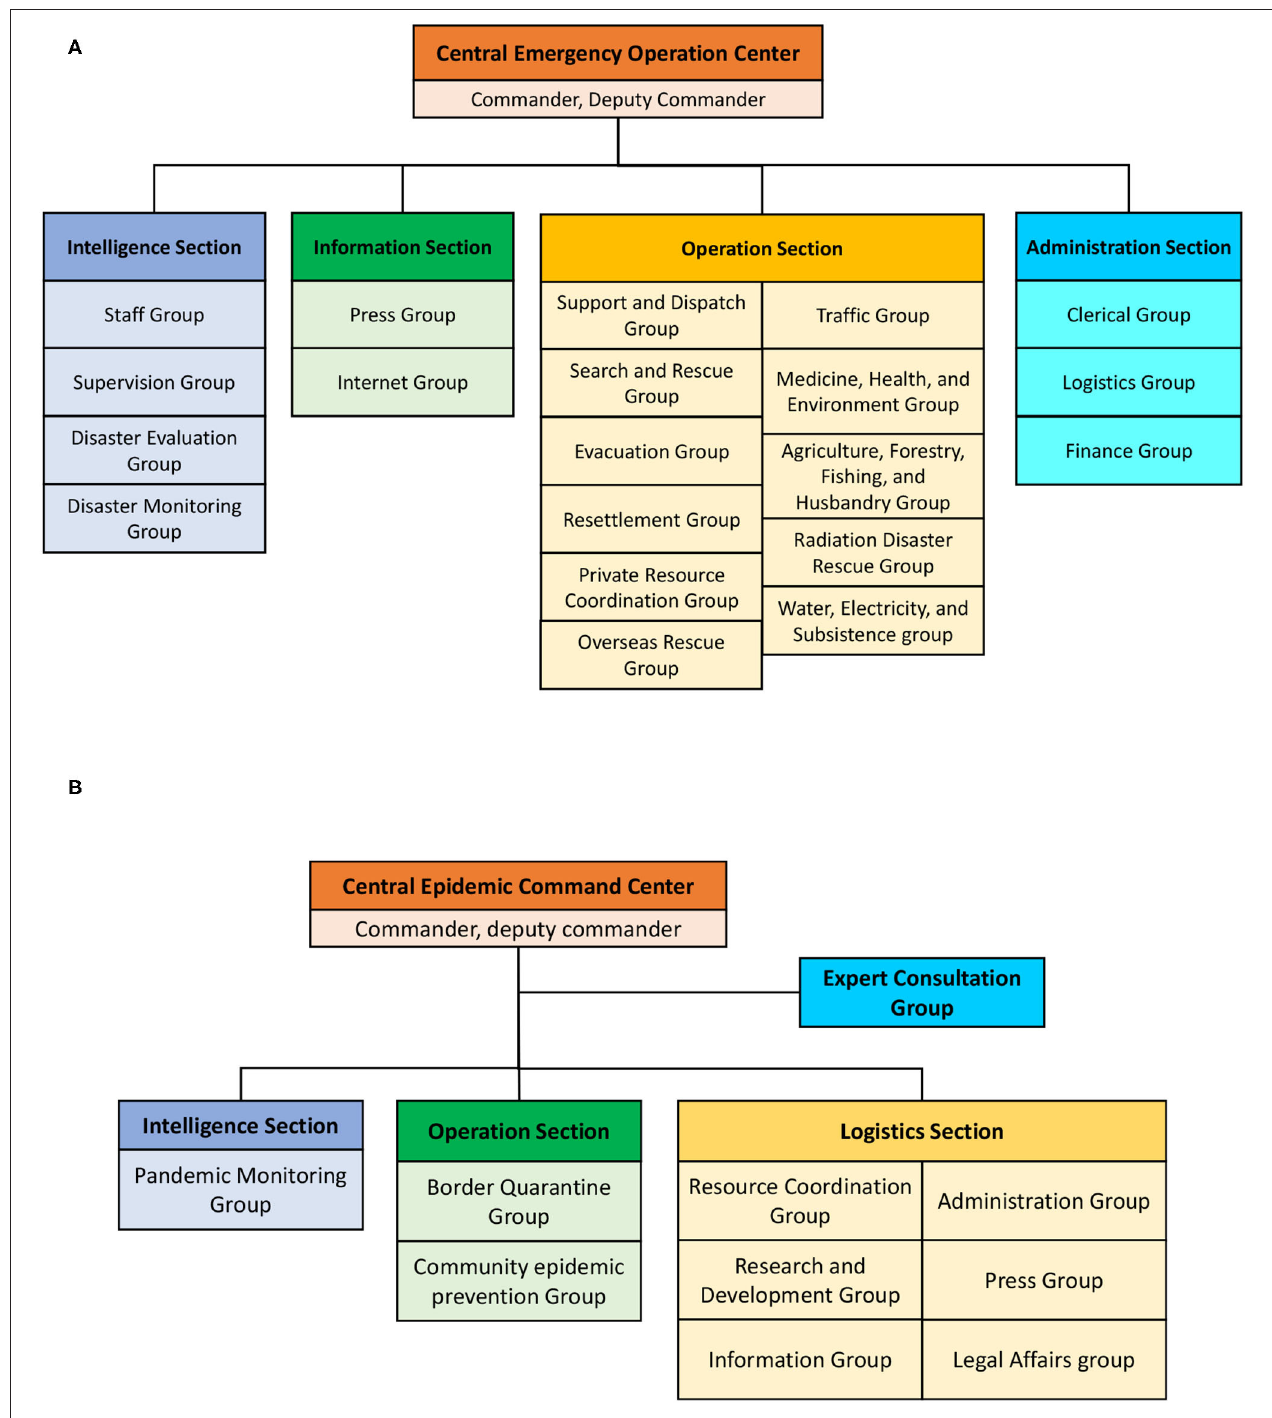
FIGURE 7 | Organizations of the central emergency operation center for (A) natural disasters and (B) communicable diseases.